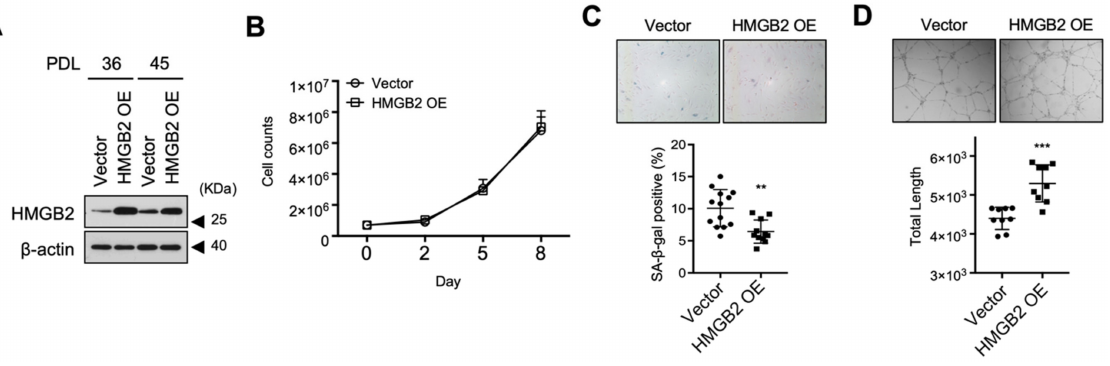
Figure 3. HMGB2 overexpression delayed replicative senescence in MVECs. ( A ) HMGB2 was overex- pressed in MVECs (PDL30) using a retrovirus system and passaged serially to PDL45. Overexpression of HMGB2 was confirmed via immunoblot analysis. ( B ) Cell proliferation was determined by count- ing the viable cells after trypan blue staining every 3 d. ( C ) Senescence in MVECs (PDL41) was determined via SA- β -gal staining and the proportion of SA- β -gal-positive cells was compared statis- tically. ( D ) The effect of HMGB2 overexpression on angiogenic potential was analyzed via in vitro tube formation assays. Representative images are shown and the total length of tube-like structures in a field was statistically compared. HMGB2 OE, HMGB2 overexpression. ** p < 0.01, *** p <